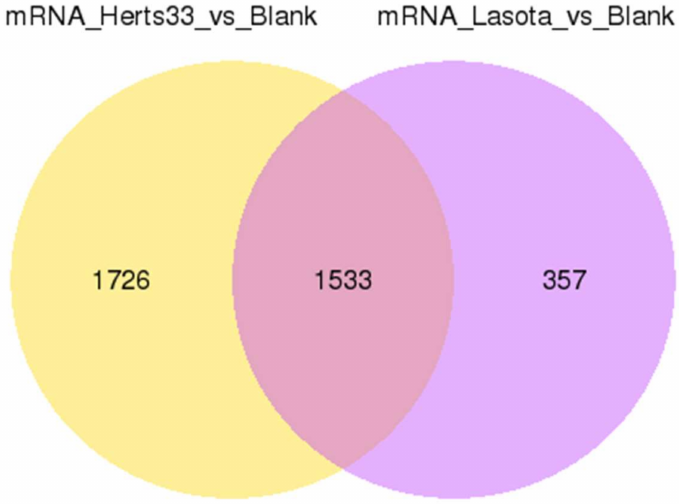
Figure 4. Summary of differentially expressed IFN-stimulated genes ( ISGs ) among the three samples. Venn diagram of common differential ISGs identified in comparison (blank vs. Herts/33 and blank vs.